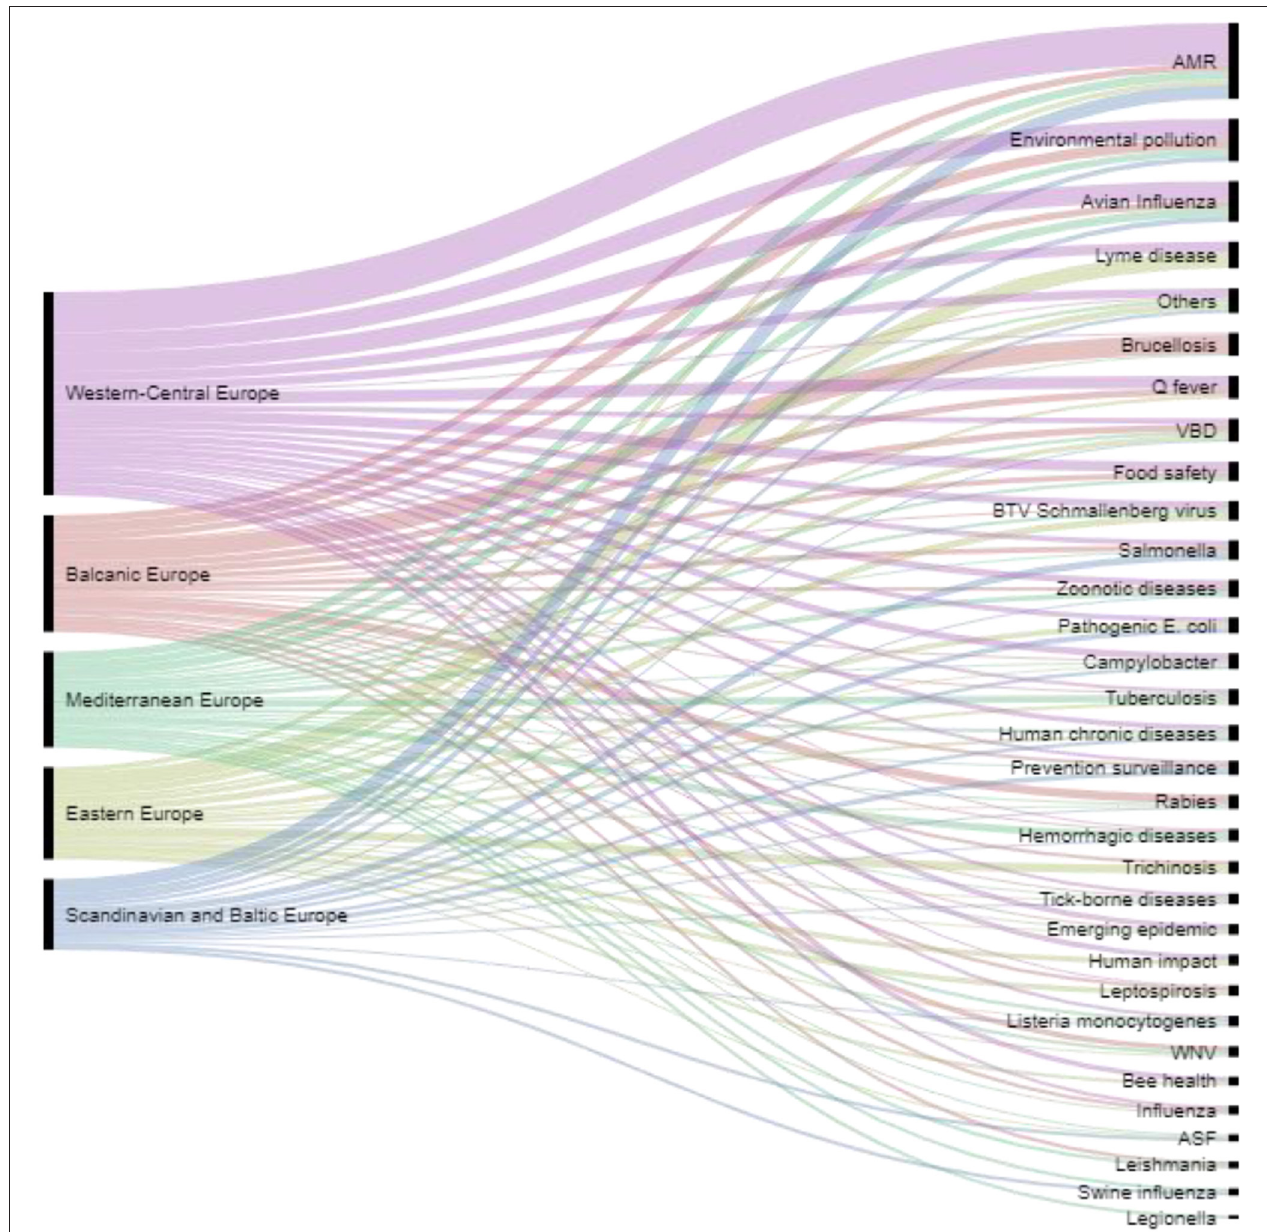
FIGURE 7 | Top environmental, animal and human health issues over the past 5 years cited by countries in the different regional